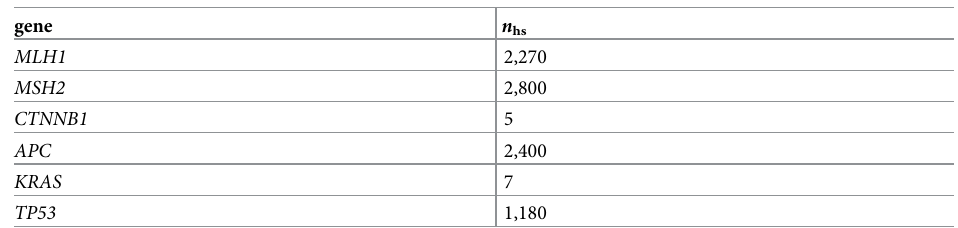
Table 1. Estimates for n hs